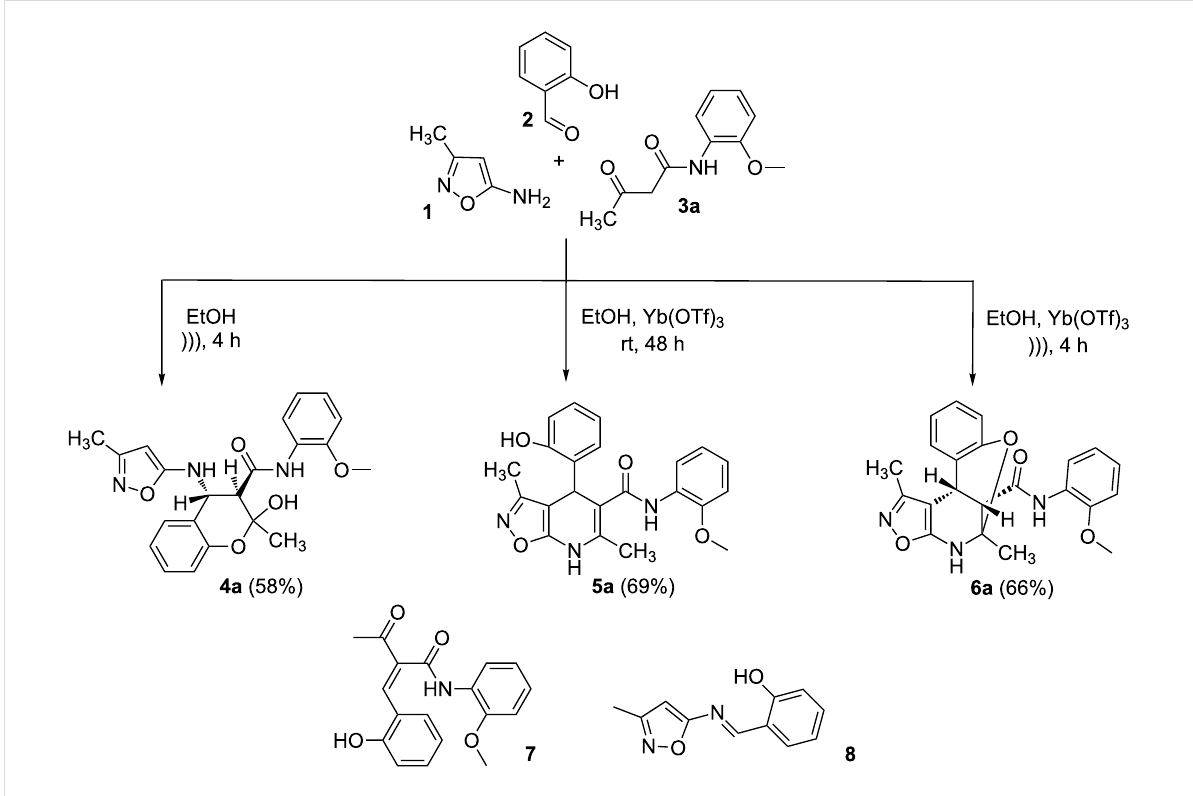
Scheme 3: Three-component heterocyclization of 5-amino-3-methylisoxazole ( 1 ), salicylaldehyde ( 2 ) and N -(2-methoxyphenyl)-3-oxobutanamide ( 3a ).